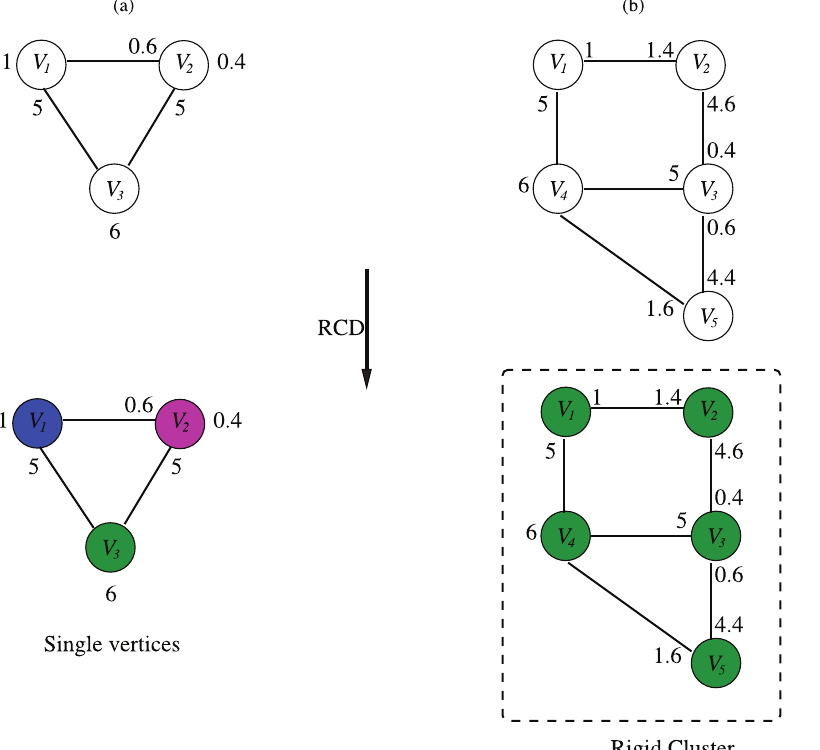
Figure 2. Two different rigid cluster decomposition examples are compared. In the first example, (a), there are 1.4 free pebbles available (located on vertices V 1 and V 2 ), whereas the capacities of edges ( V 1 , V 2 ) , ( V 1 , V 3 ) , and ( V 2 , V 3 ) is, respectively, 0.6, 5.0, 5.0. If a hypothetical edge is added between any pair of vertices, there is always going to be possible to find DOF, therefore the three vertices result in single bodies (highlighted by color differences). Conversely, in the second example, (b), only the six trivial DOF can be found (on vertex V 4 ). That is, no free pebbles remain in the network (they have all be consumed by the edges). As such, the five vertices belong to a single rigid cluster.